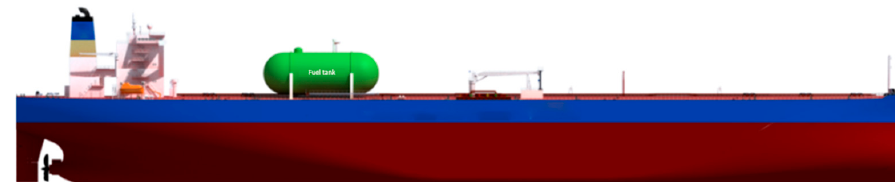
Figure 1. Side view of the VLCC.